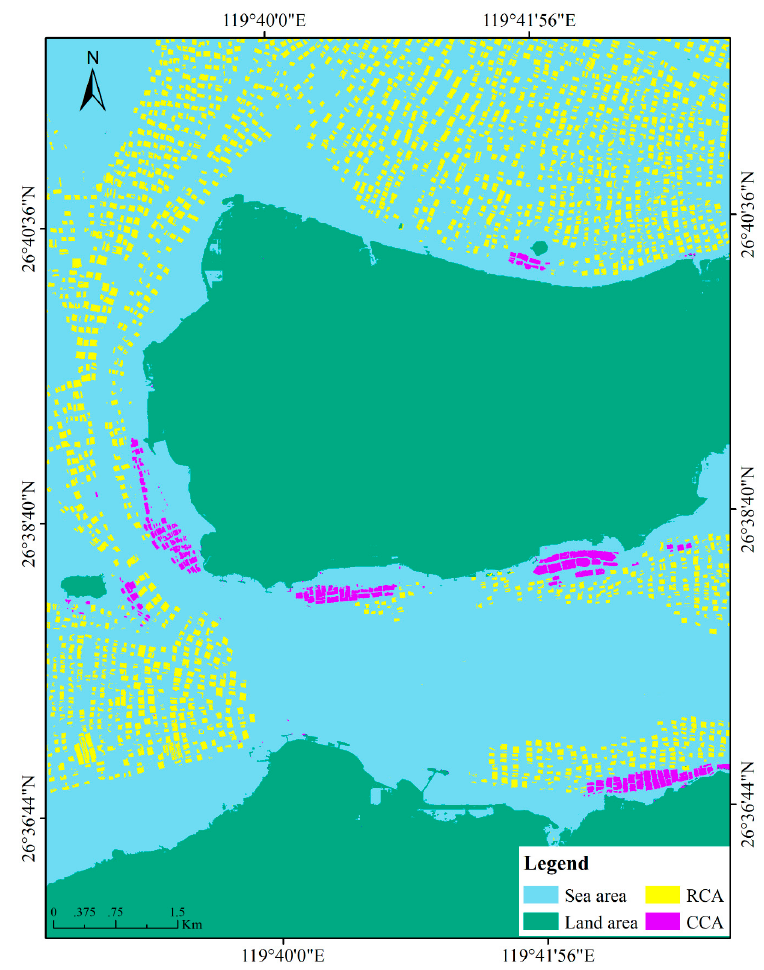
Figure 6. Classification results of CCA and RCA using our proposed method.